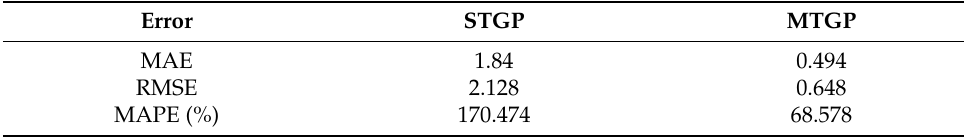
Figure 8. Prediction results of MT-LSTM, ST-LSTM, and LSTM for S3. Table 3. Error results of STGP and MTGP for S3. Error